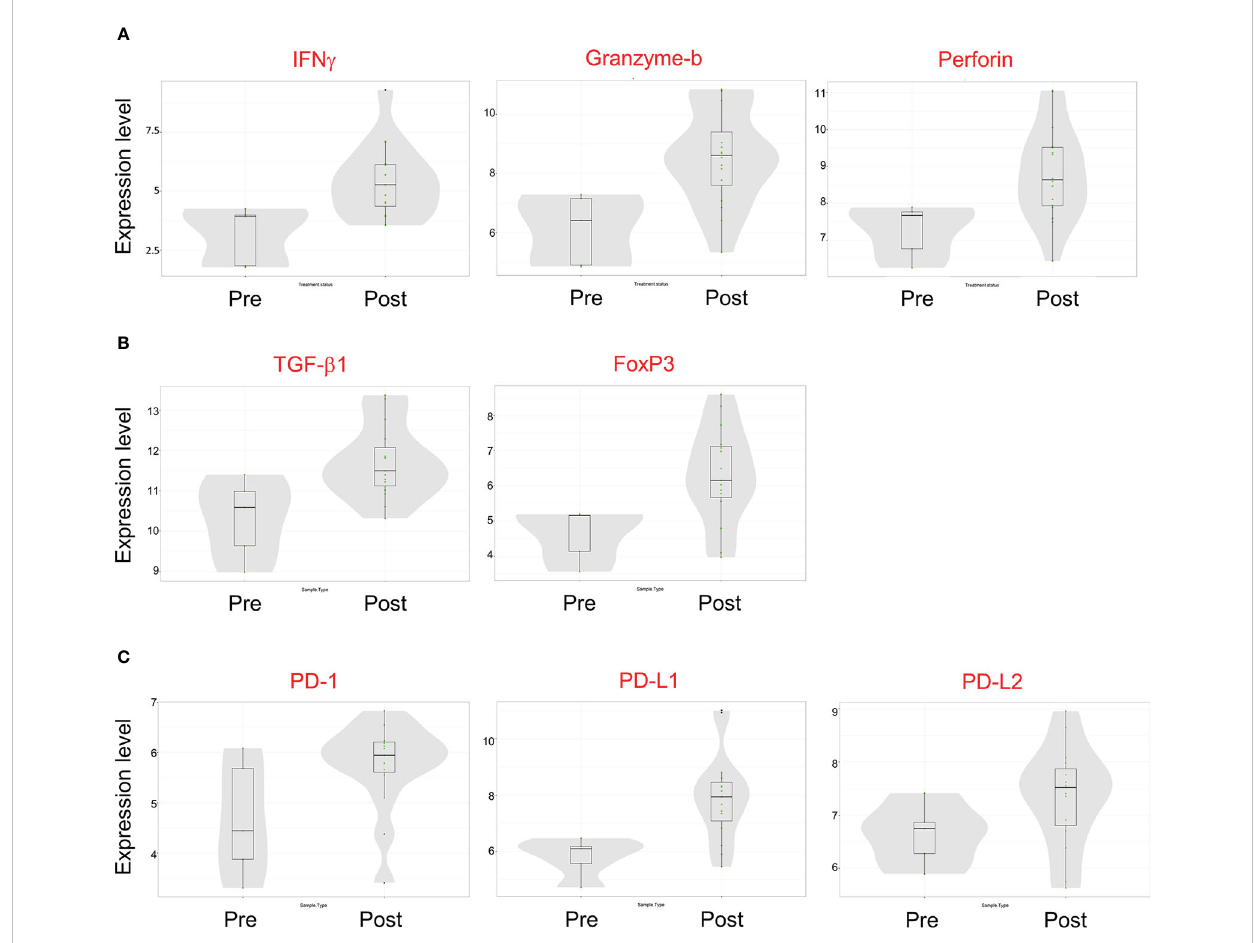
FIGURE 7 mRNA transcript expression of immune-modulatory proteins before and after Olvi-vec therapy. (A – C) Total RNA was isolated from MPM tumor sections before and after Olvi-vec therapy. The number of mRNA transcripts for (A) immune effector proteins, (B) immune suppressive proteins, and (C) immune checkpoint regulatory proteins were quanti fi ed. Bars indicate mean, interquartile range, and range.